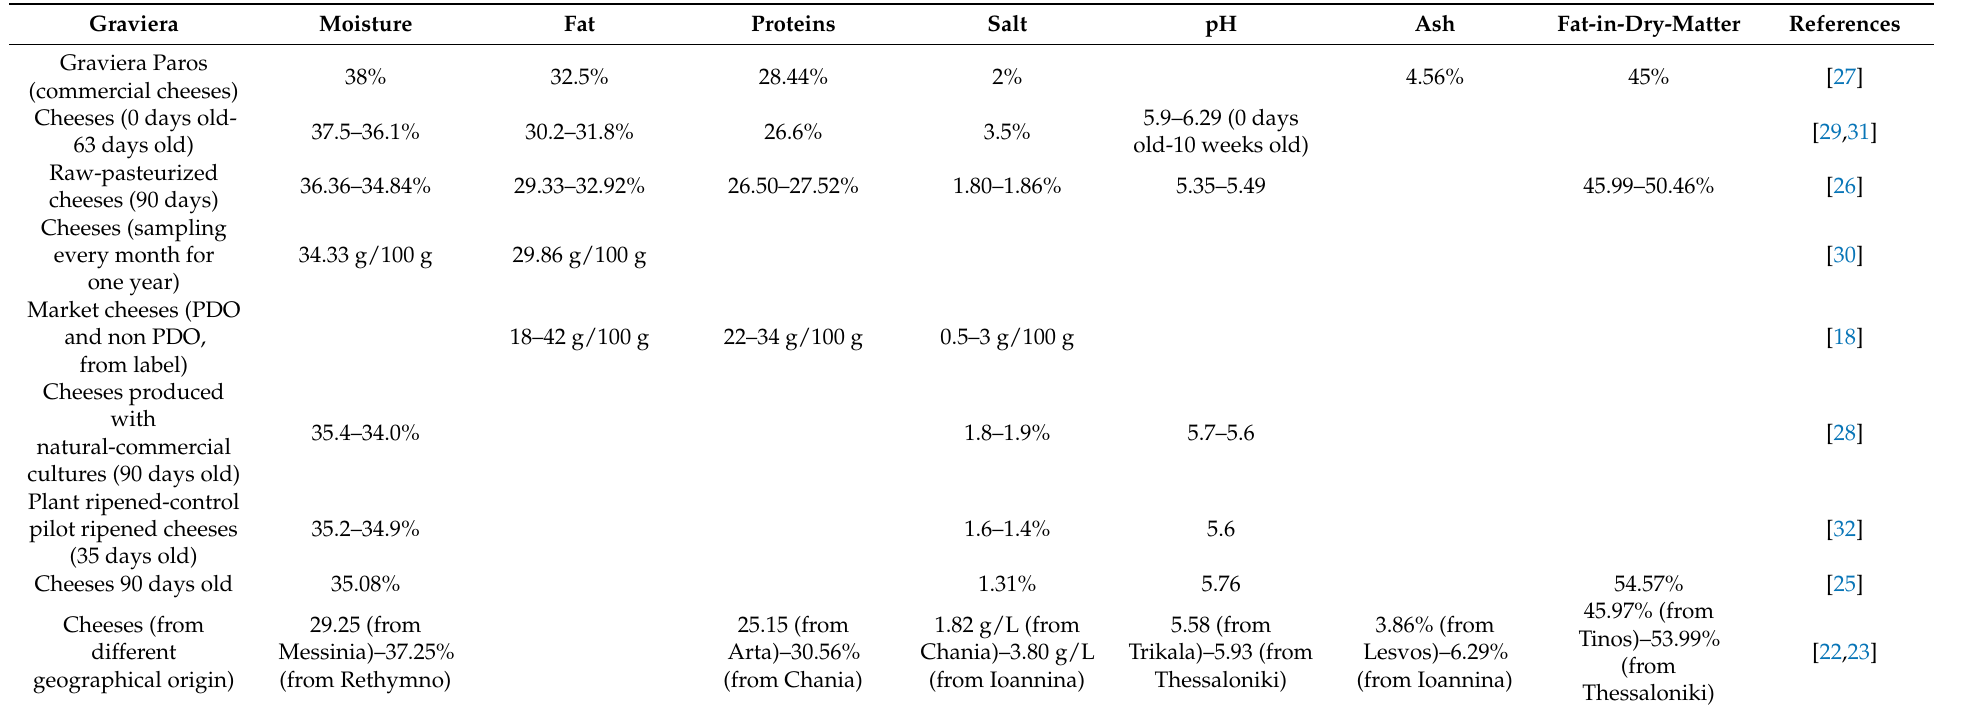
Table 4. Composition of Graviera